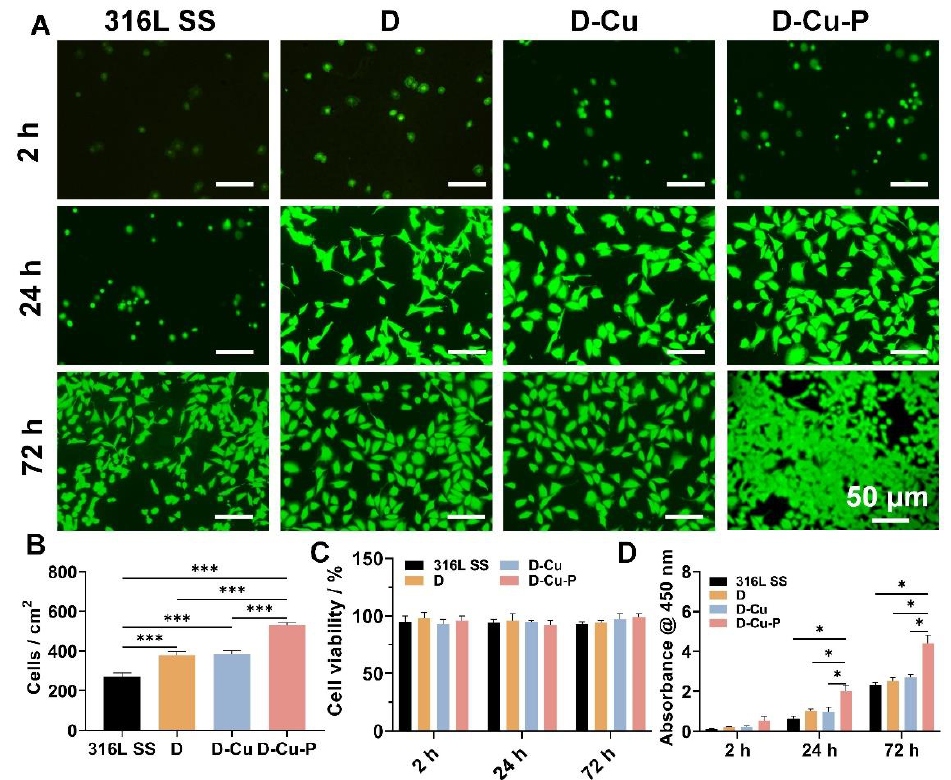
Figure 3. The biocompatibility and cell recruitment evaluations of the coated samples. ( A ) Live/dead staining of the HUVECs after 2, 24, and 72 h. ( B ) Cell adhesion rate, ( C ) viability, and ( D ) proliferation rate of the samples. * p < 0.05 and *** p < 0.001 denote the statistical significance.